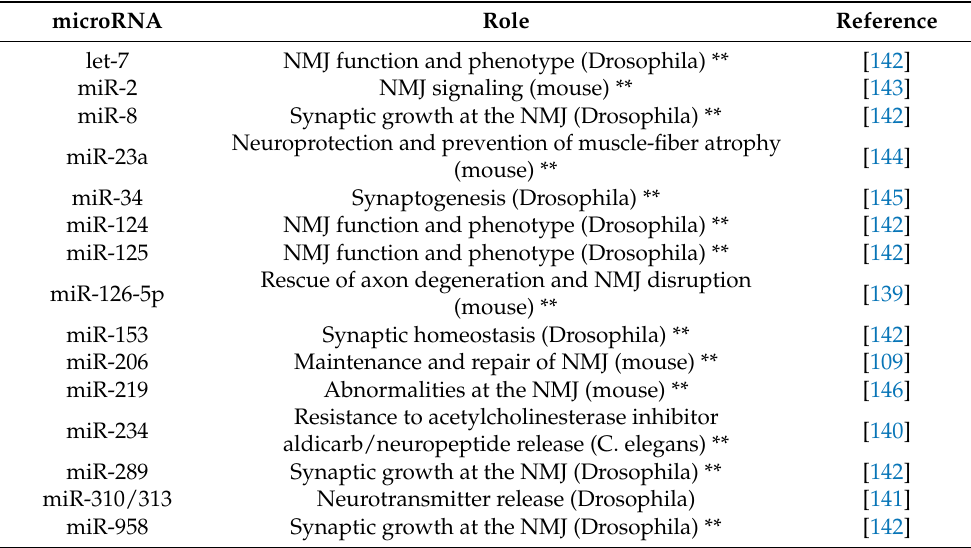
Table 5. MicroRNAs in Neuromuscular Junction